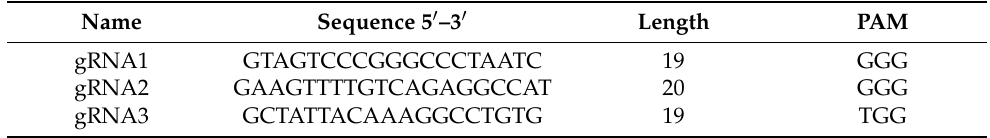
Table 1. Selected gRNAs sequences with PAM type located upstream used for carrot F3H gene editing.